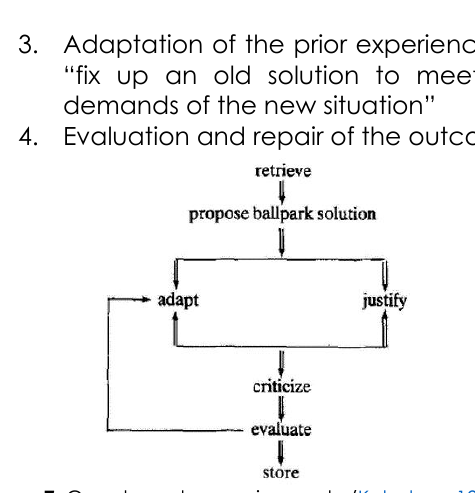
Figure 7. Case-based reasoning cycle (Kolodner, 1992, p.